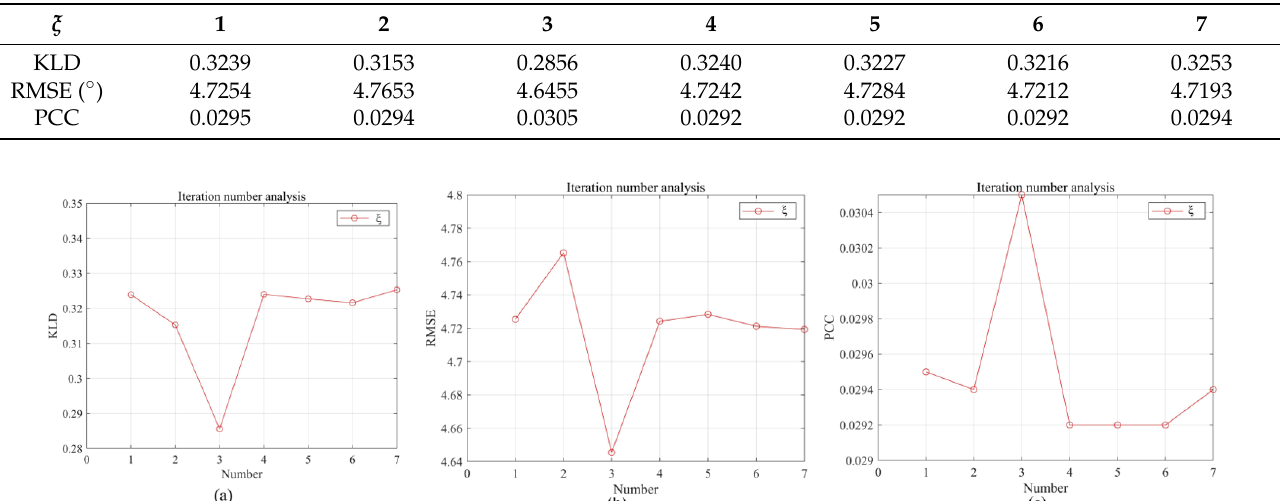
Figure 11. Wind direction sequence obtained by FC-GLCM algorithm when iteration number ξ is different. ( a ) KLD index; ( b ) RMSE index; ( c ) PCC index.